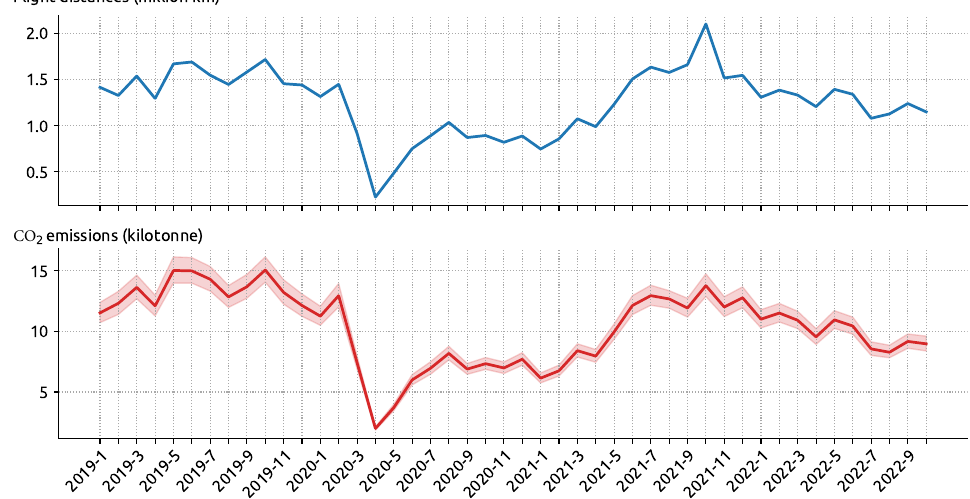
Figure 4. Flight CO 2 emissions by selected around 250 private jets from 2019 to 2022. The total CO 2 emissions is between 0.45 and 0.5 megatonnes (billion